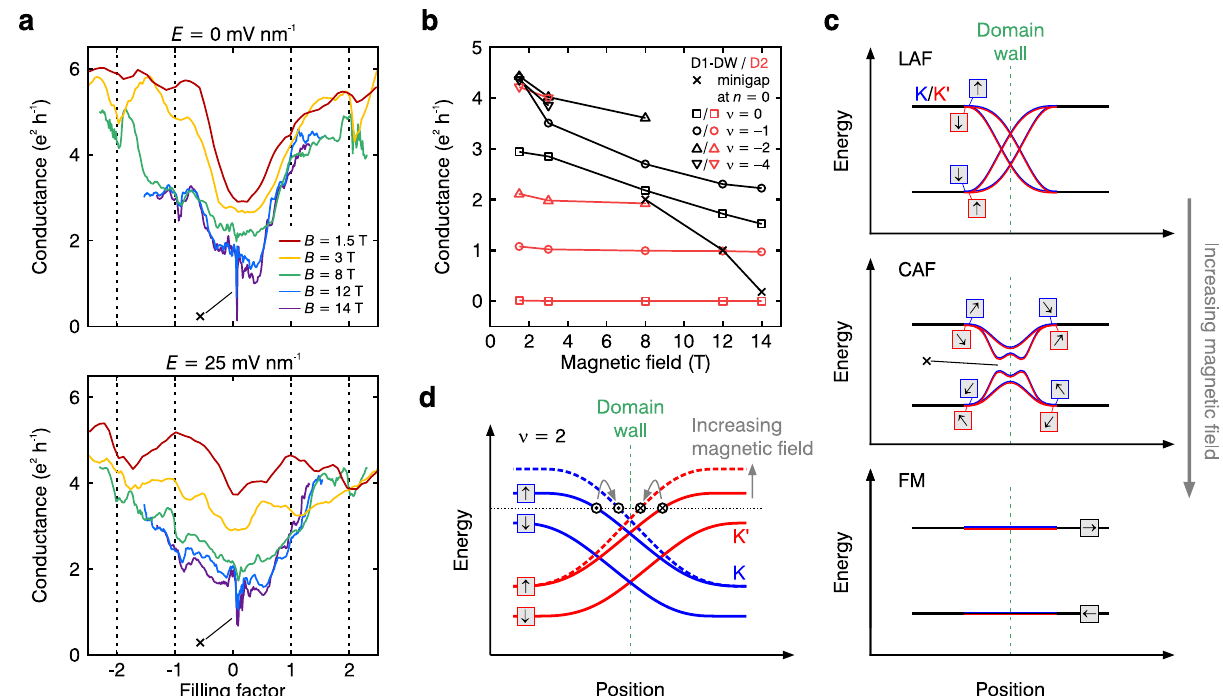
Fig. 3 Behaviour of the kink states for varying magnetic fi eld. a Conductance as a function of fi lling factor shown for various magnetic fi elds at E = 0 (top) and E = 25 mV nm − 1 (bottom) measured in device D1-DW. The cross indicates the sharp conductance dip caused by the opening of a minigap. Note, that the state emerging around zero density is the LAF/CAF state, only at E = 25 mV nm − 1 the data curve for B = 1.5 T shows the transition between LAF/CAF and LP phase, see also Supplementary Fig. 2. b Conductance of the ν ¼ 0 ; (cid:3) 1 ; (cid:3) 2 ; (cid:3) 4 quantum Hall states as well as within the minigap as a function of magnetic fi eld. The data for device D1-DW (D2) is shown in black (red). c Schematic band structure around the domain wall shown for the LAF, CAF and FM ν ¼ 0 phases. The blue (red) lines indicate the chiral states in the K(K 0 )-valley. The cross indicates the spectral minigap emerging in the CAF phase. d Schematic band structure for ν ¼ 2 (orbital index is implicit) in the presence of layer-polarising bias. The domain wall retains only two pairs of valley helical (spin polarised) states, indicated by black circles with in-plane and out-of-plane directions. Their backscattering rate at the chemical potential (thin horizontal line) depends on their spatial separation and width. Both are generally expected to change as a function of magnetic fi eld, leading to a change in DW conductance. The in fl uence of the magnetic fi eld is indicated by grey arrows. A similar effect was observed in arti fi cial domain walls 7